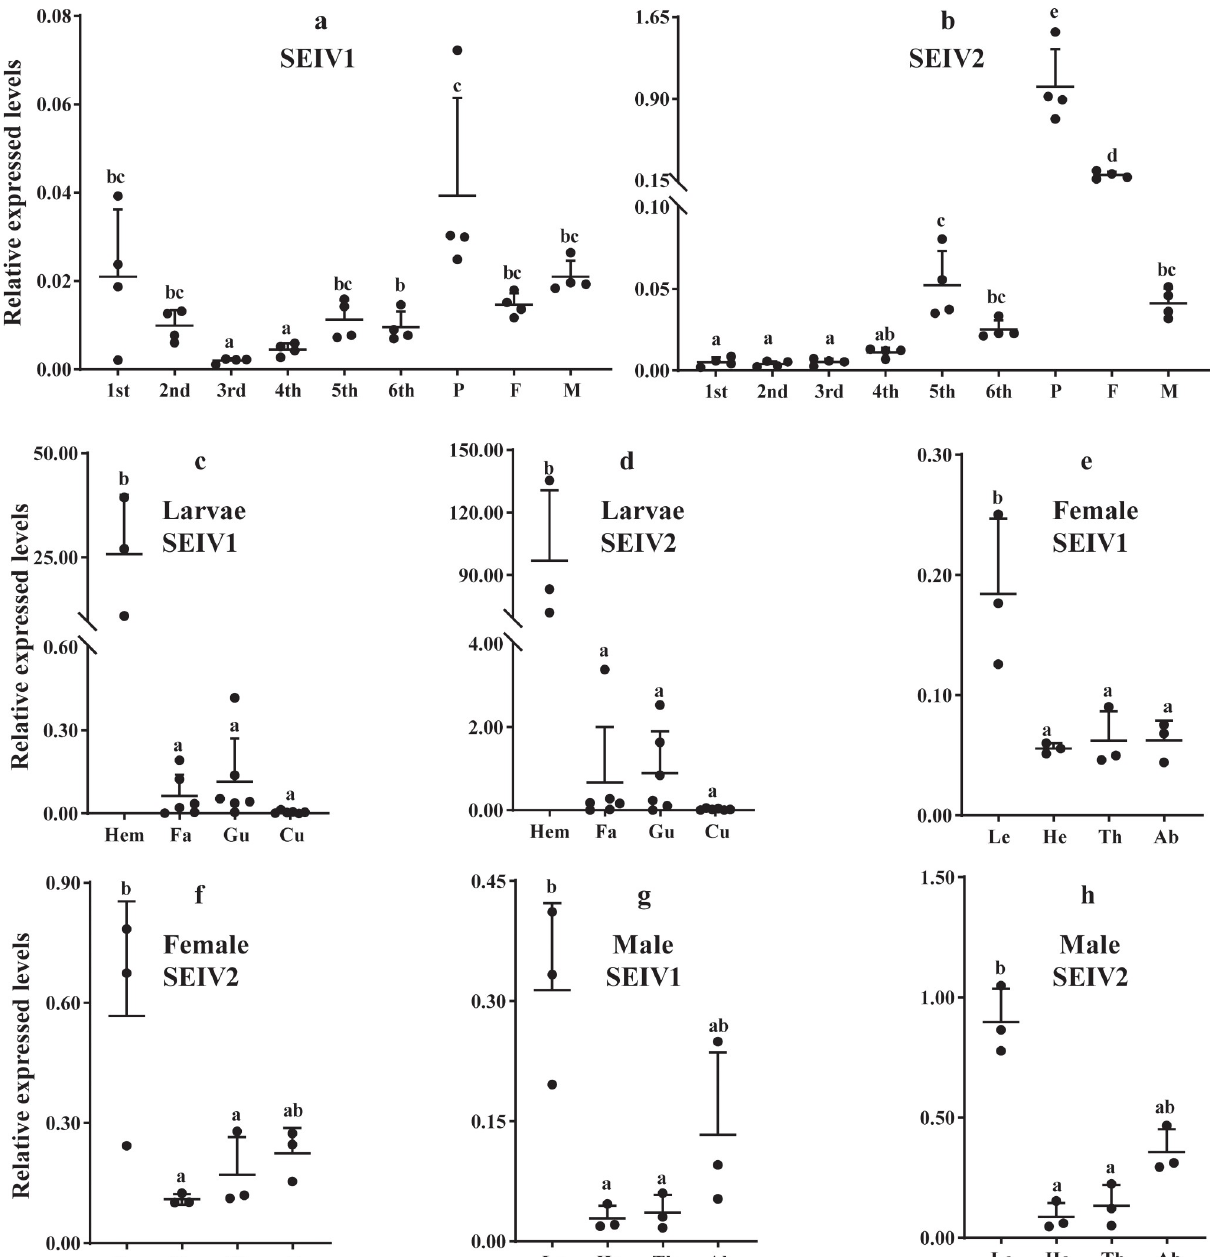
Fig 2. Distribution of the partiti-like viruses in S . exempta . (a,b) Relative quantification of SEIV1 (a) and SEIV2 (b) using β -actin and GAPDH as reference genes at different stages (n = 4) (ANOVA: SEIV1: F = 10.111, d.f. = 8,27, P < 0.0001; SEIV2: F = 100.73, d.f. = 8,27, P < 0.0001). (c,d) Relative quantification of SEIV1 (c) and SEIV2 (d) in different tissues of larvae (for hemolymph, n = 3; others, n = 6) (SEIV1: F = 26.827, d.f. = 3,17, P < 0.0001; SEIV2: F = 13.819, d.f. = 3,17, P < 0.0001). (e,f) Relative quantification of SEIV1 (e) and SEIV2 (f) in different tissues of female (n = 3) (SEIV1: F = 10.875, d.f. = 3,8, P = 0.0034; SEIV2: F = 6.681, d.f. = 3,8, P = 0.0143). (g,h) Relative quantification of SEIV1 (g) and SEIV2 (h) in different tissues of male (n = 3) (SEIV1: F = 11.114, d.f. = 3,8, P = 0.0032; SEIV2: F = 14.539, d.f. = 3,8, P = 0.0013). 1 st = first instar-stage larvae, 2 nd = second instar-stage larvae, 3 rd = third instar-stage larvae, 4 th = fourth instar-stage larvae, 5 th = fifth instar-stage larvae, 6 th = sixth instar-stage larvae, p = pupae, F = Female, M = Male, Hem = Hemolymph, Fa = Fat body, Gu = Gut, Cu = Cuticle, Le = leg, He = Head, Th = Thorax, Ab = Abdomen. Means ± SD. Different letters indicate statistically significance